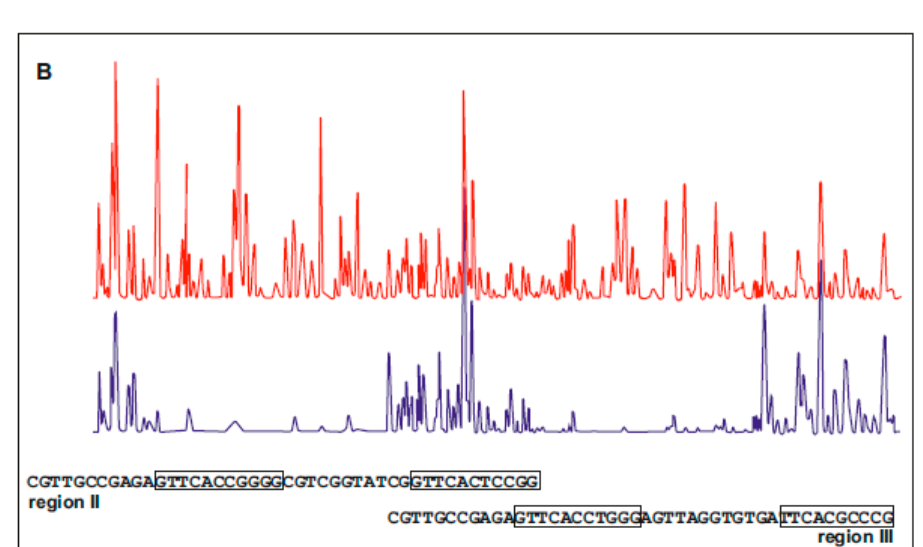
Figure 5. Localization of PHO boxes in the intergenic region phoRP-PhoU of S. hygroscopicus var. geldanus NRRL 3602. ( A ) Sequence of the intergenic region phoRP-phoU showing in red the nucleotides belonging to the phoP and phoU genes. The regions I, II, and III used in EMSA analysis are indicated. ( B ) Footprinting analysis of DNA containing regions II and III. The upper line (in red) corresponds to the parental strain DNA without the PhoP DBD -GST protein. The lower line (in blue) corresponds to the same DNA sequence protected by addition of PhoP DBD -GST protein. PhoP DBD -GST protein (2 μ M) was used in the assay as described by Sola-Landa et al. [66].